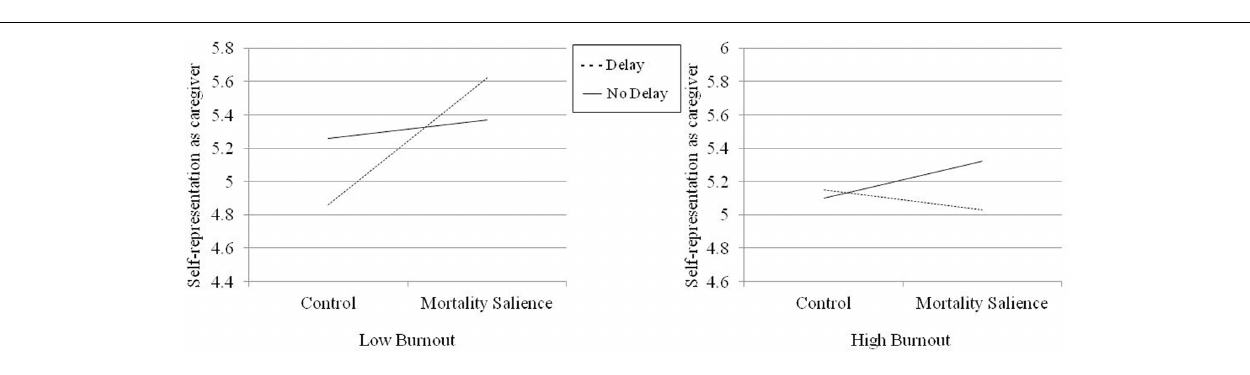
FIGURE 3 | Representation of the self as a valuable caregiver as a function of MS and delay at low and high levels of